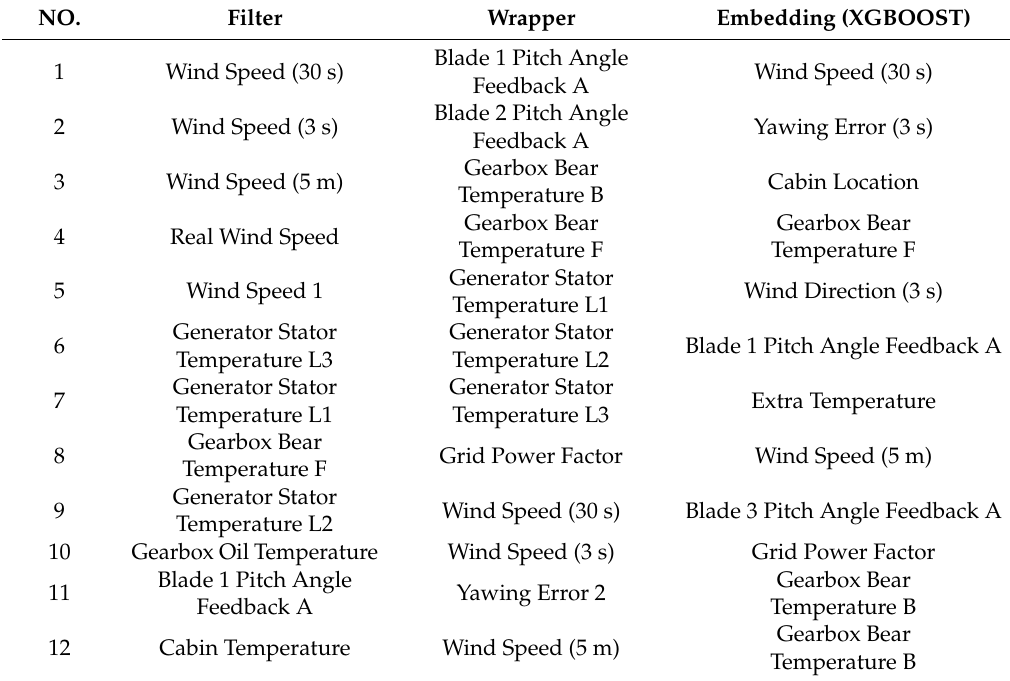
Table 3. Result of three feature selection